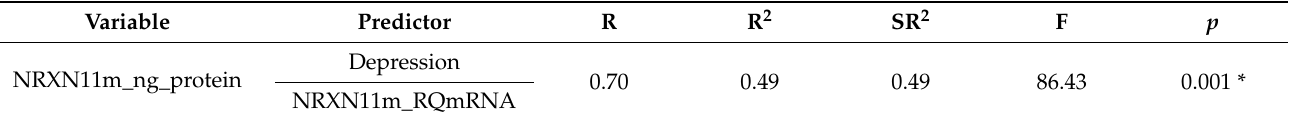
Table 4. Variable regression summary—expression of the studied gene in the examined groups including predictors: expression of the studied gene at the mRNA level and the occurrence of depression.